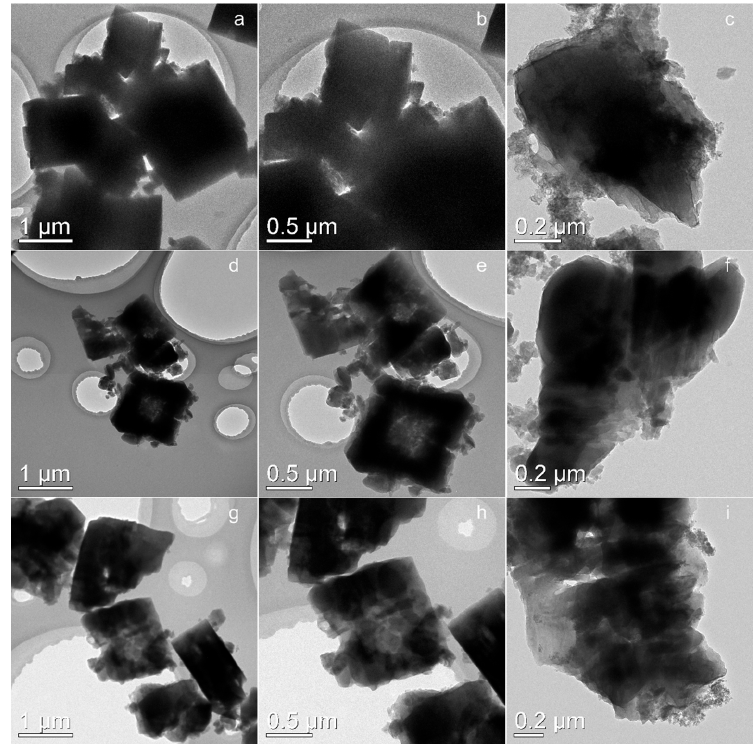
Figure 5 . SEM images of the as-synthesized SAPO-34 samples with and without PUa as mesoporogen.